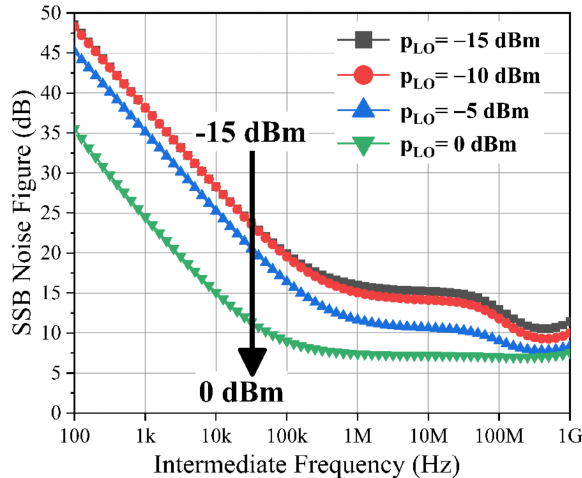
Figure 6. Simulated flicker noise of mixer with different LO (local oscillator)